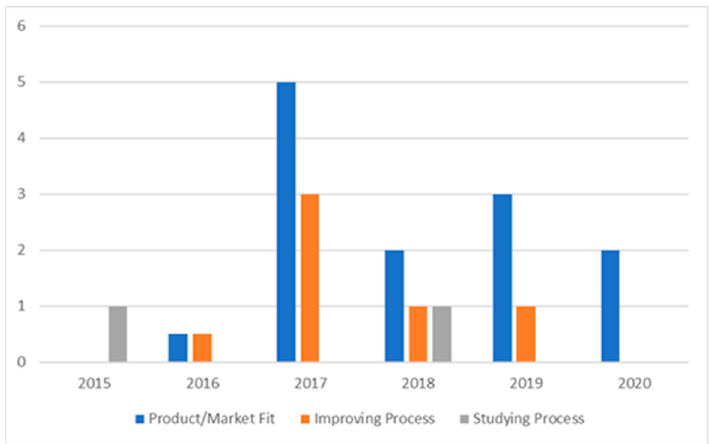
Figure 3. Research evolution in terms of underlying motivation for research.